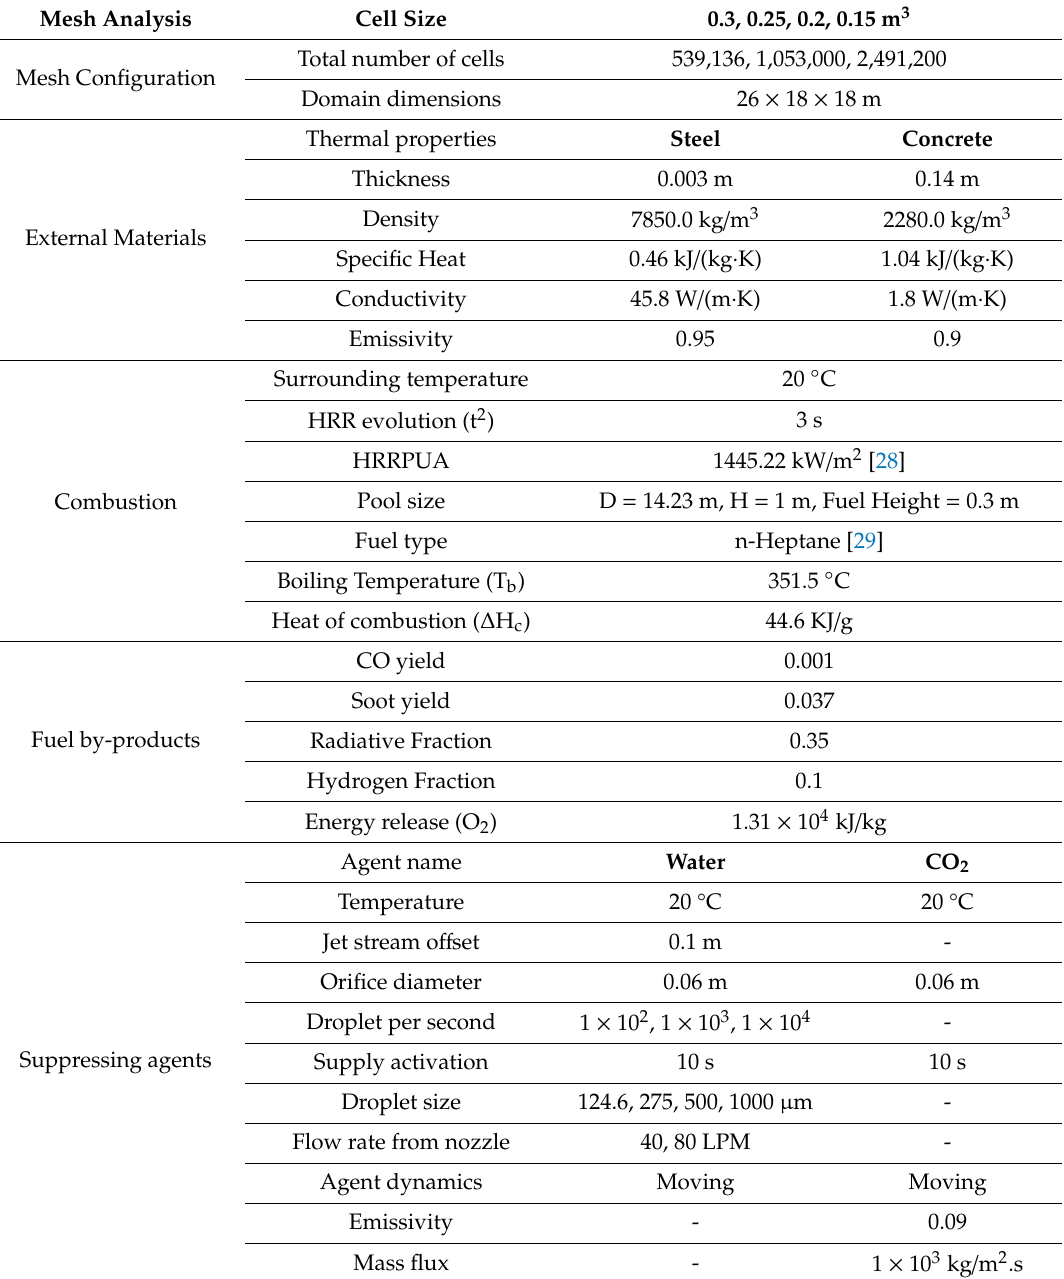
Table 1. Initial conditions and input parameters of the